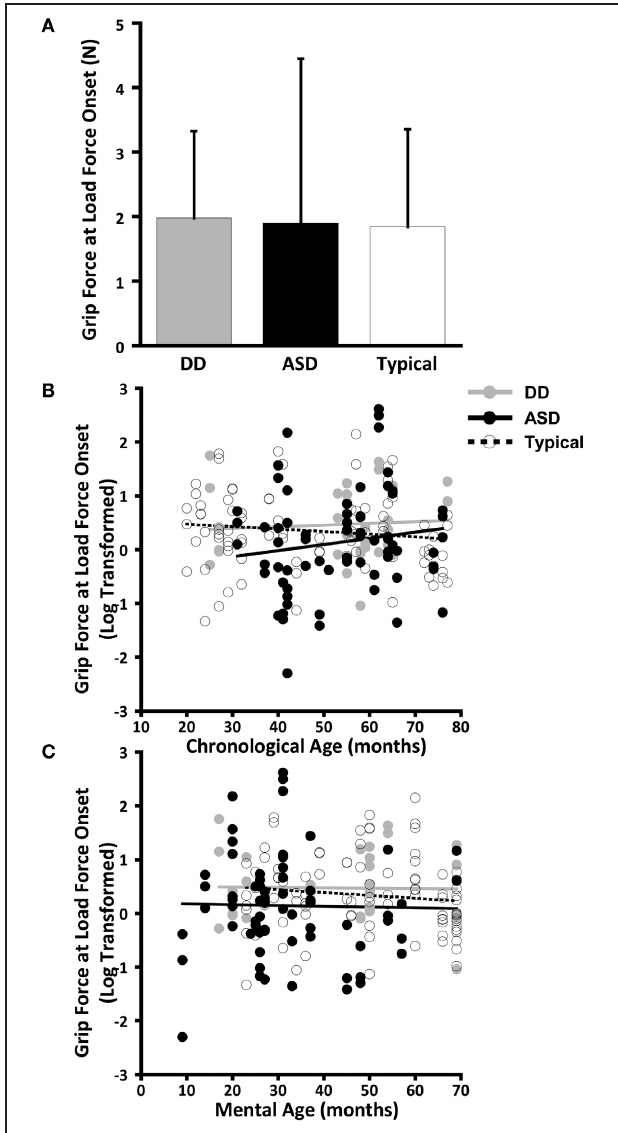
FIGURE 4 | Grip force at onset of load force. (A) Means and standard deviations. (B) The effect of chronological age. (C) The effect of mental age.